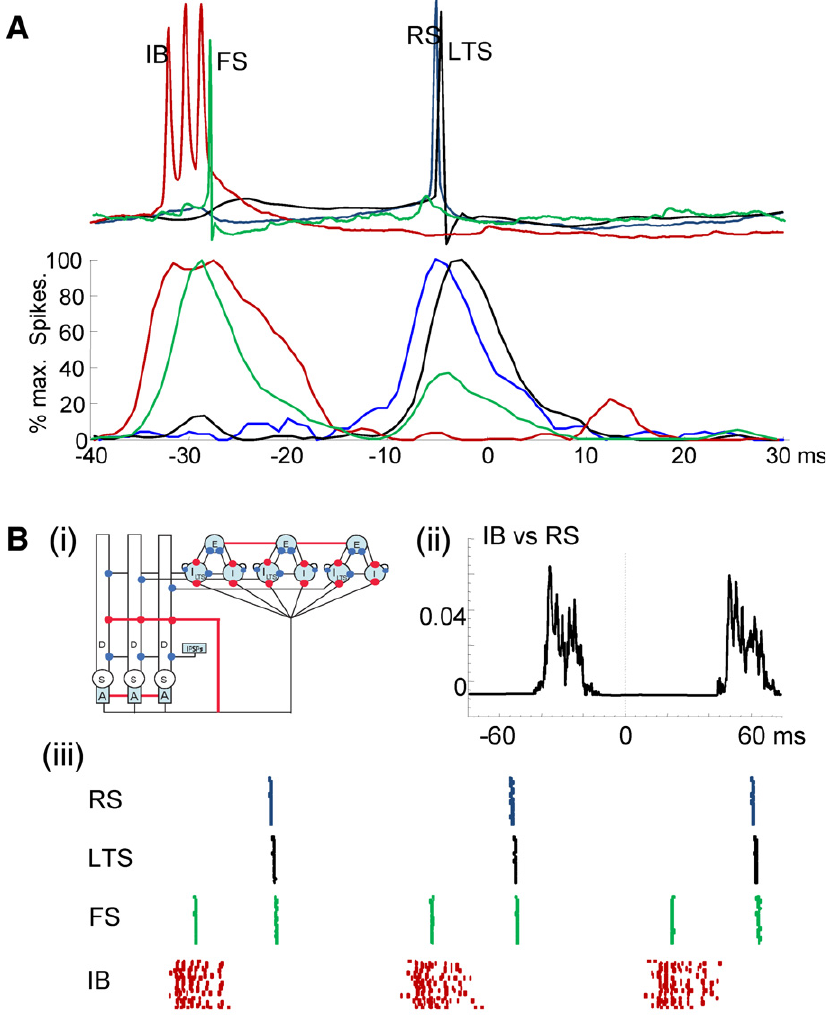
Figure 4. Experimental and computational modeling evidence for recurrent, sequential activation of deep and superfi cial laminae during the beta1 population rhythm. (A) Example membrane potential changes in each neuron type temporally aligned to peak positivity in concurrently recorded fi eld poten- tials. Lower graph shows pooled action potential distributions for IB (red), FS (green), RS (blue) and LTS (black) cells. Note IB and superfi cial layer FS neurons fi re approximately one gamma period before RS and LTS cells in superfi cial layers. (B) (i) Cartoon representation of the computational model. The populations in both layers consist of twenty cells, although we only draw three of each cell type in the fi gure. The deep layer consists of IB cells of three compartments: D, the dendrite; S, the soma; and A, the axon. The superfi cial layer contains three cell types: RS cells (E), basket cells (I), LTS cells (LTS). Termination points of excitatory and inhibitory synapses are illustrated by red and blue circles, respectively. We connect all of the IB cell axons and RS cells with gap junctions (indicated by the red lines). (ii) The average cross-correlation between the spiking activity of the RS cell population and IB cell population. (iii) The spiking activity of the superfi - cial layer cells (FS, RS and LTS cells) and layer V (IB cells). Each colored dot represents a spike in a single compartment. The horizontal line indicates 20